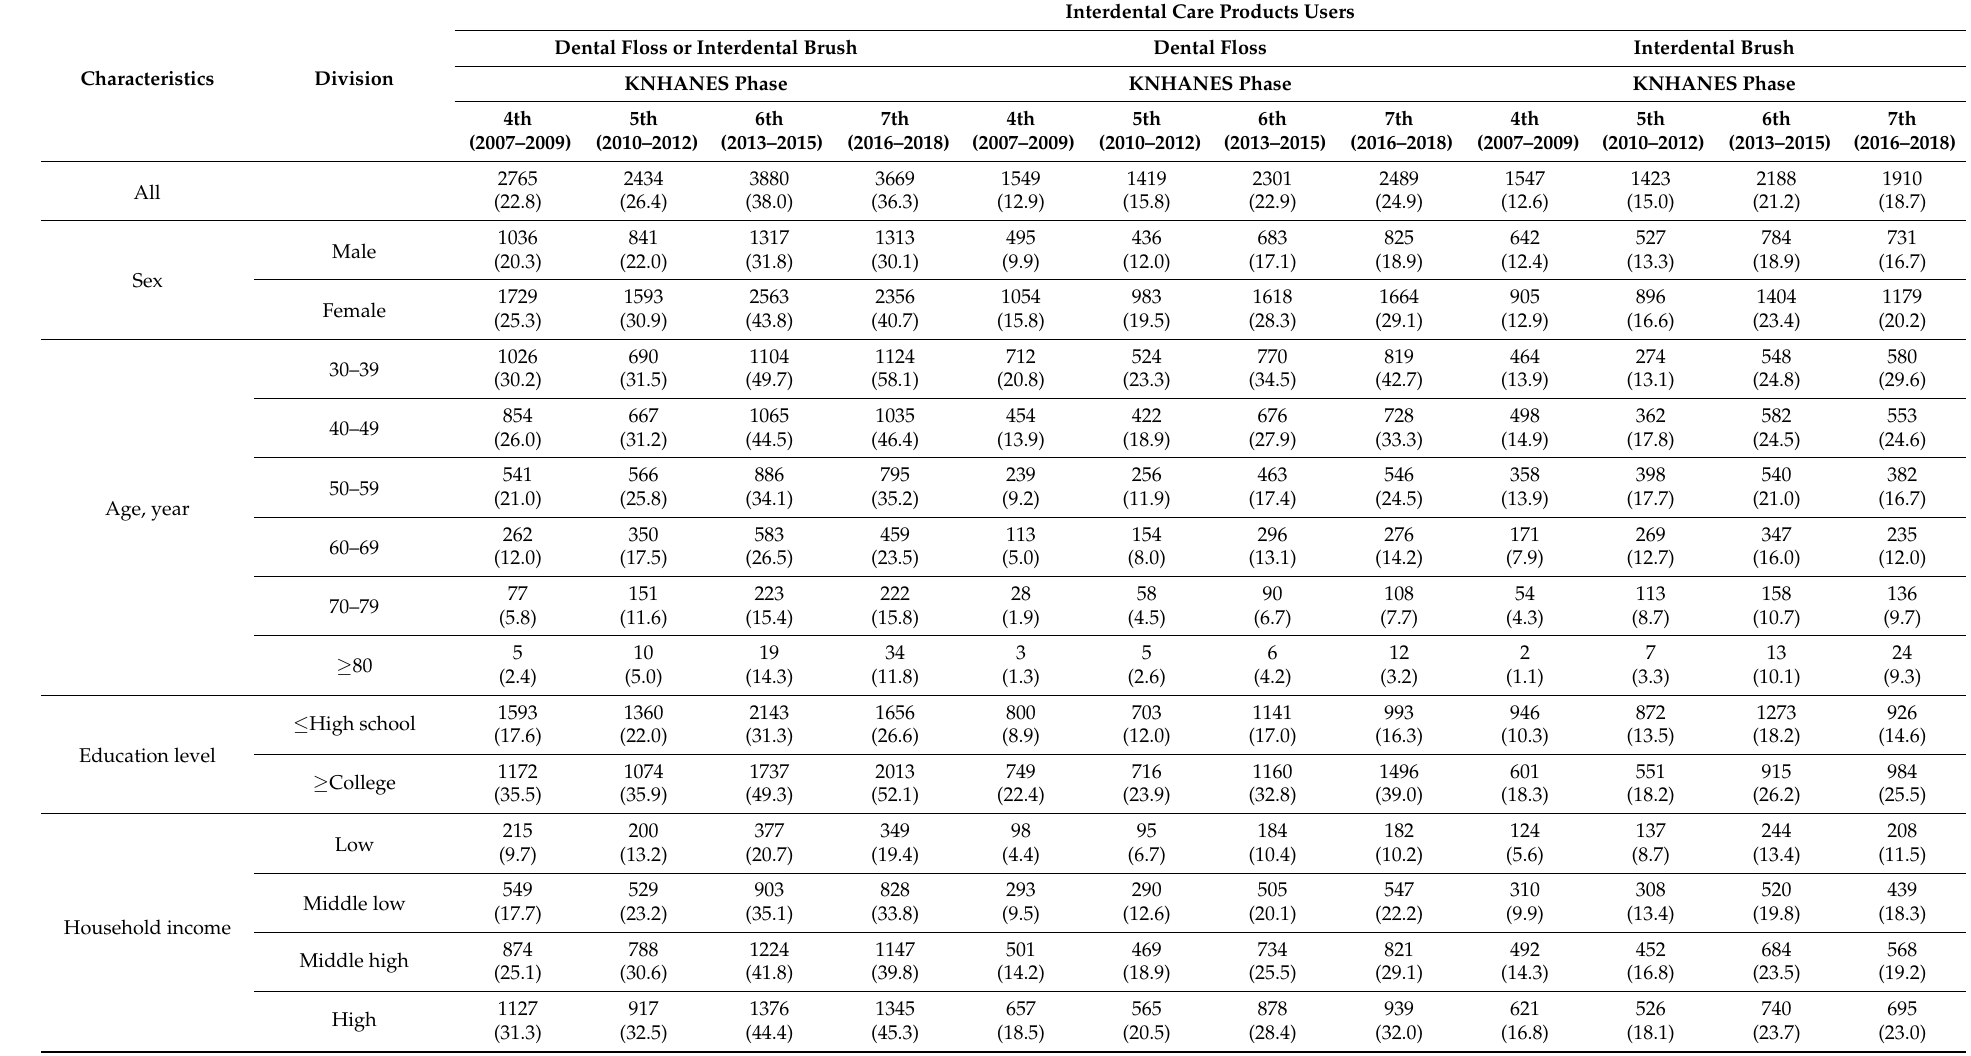
Table 2. Characteristics of dental floss and/or interdental brush